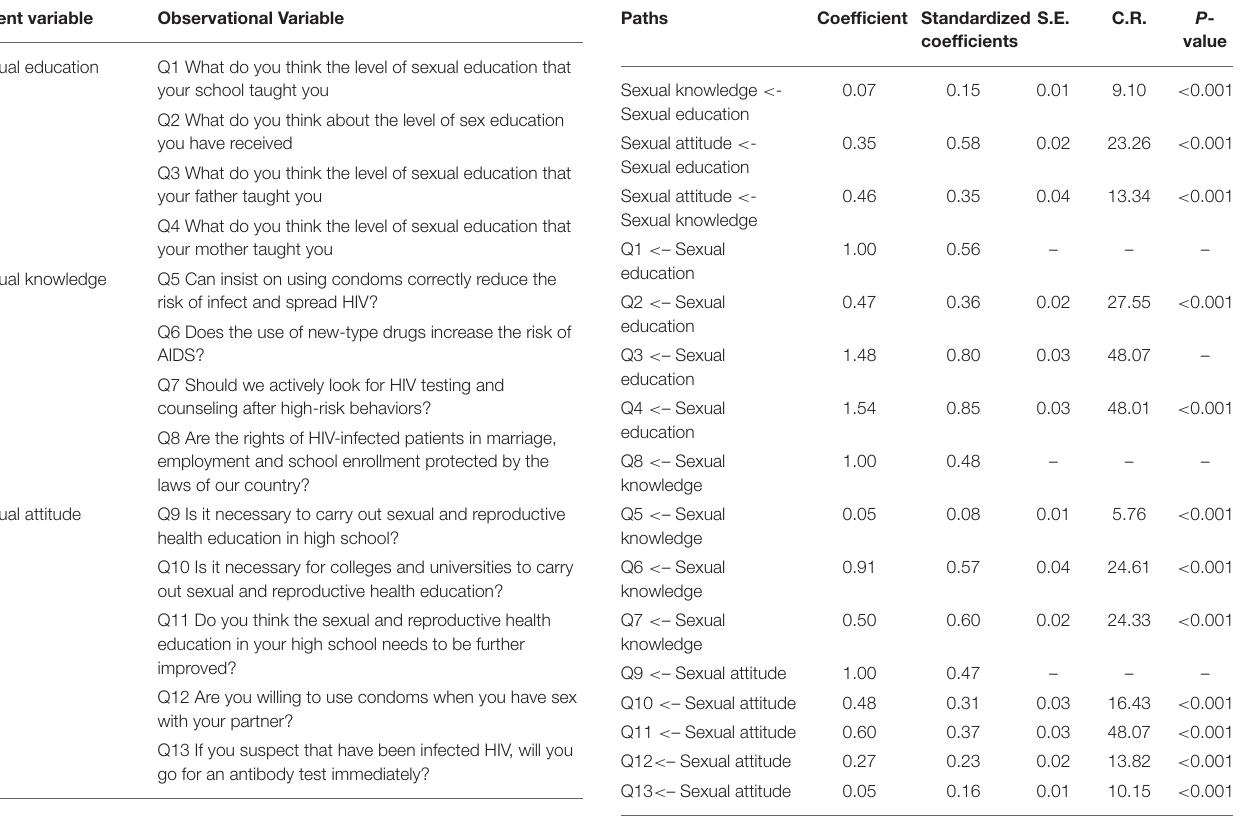
TABLE 4 | Latent variable and observational variable. TABLE 5 | Model results of each